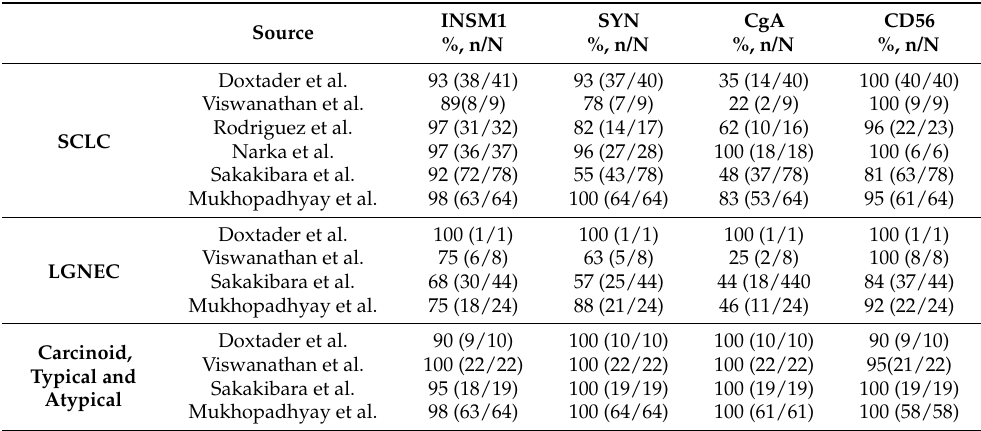
Table 1. The summary of immunohistochemical expression of INSM1, synaptophysin, chromogranin, and CD56 in pulmonary neuroendocrine